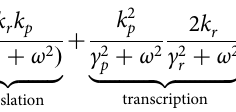
transcription and mRNA degradation, given by a single-species birth-death network with rate of production k and the rate of degradation γ